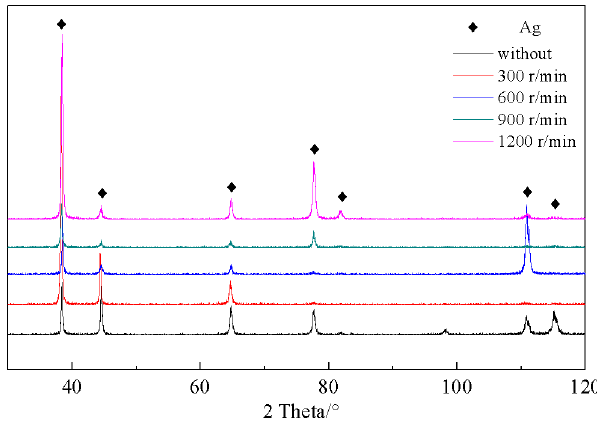
Figure 4. XRD patterns of the Ag–1.5Cu–1.0Y alloys under different rotation speeds.